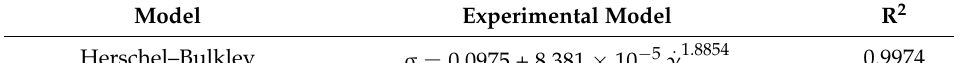
Table 1. Herschel–Bulkley experimental model parameters for fermented mash at 25 °C.